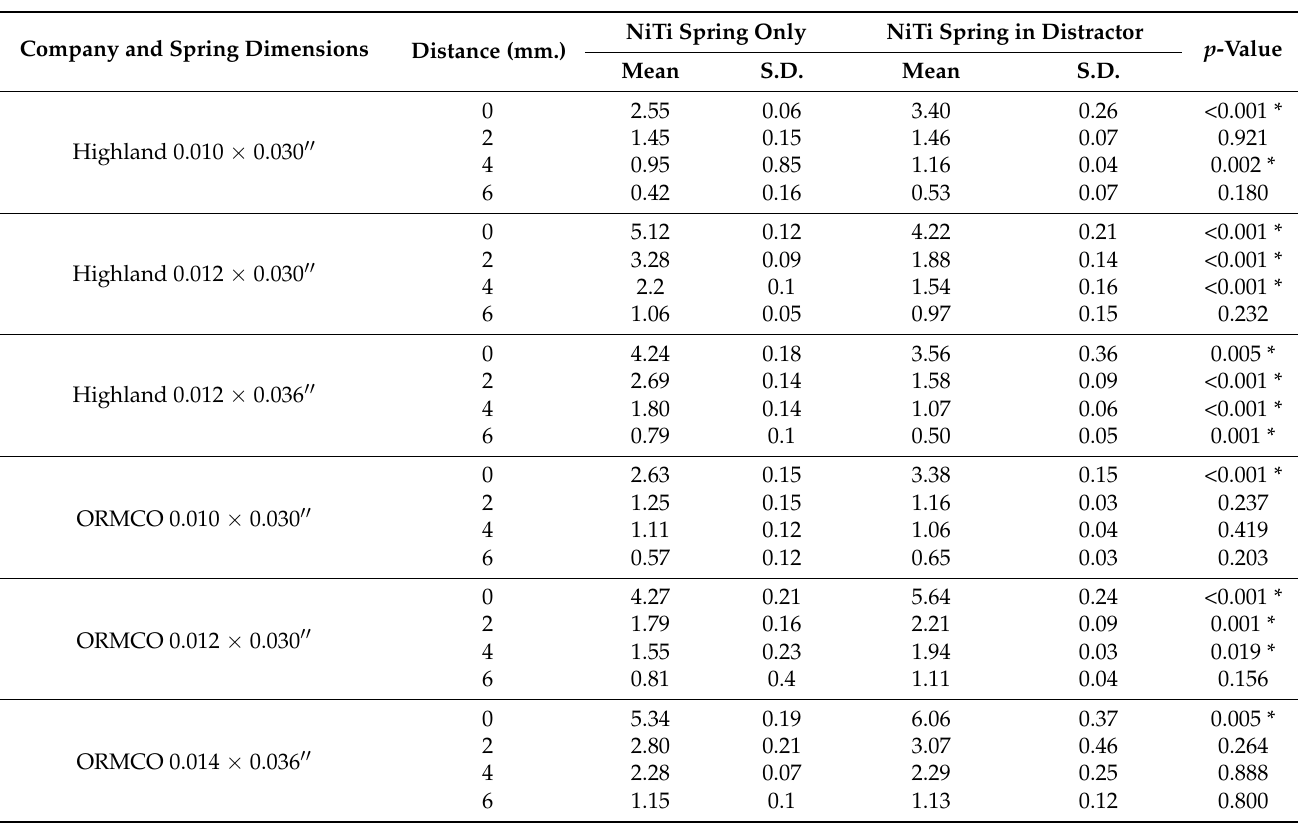
Table 3. Comparison of the mean load between NiTi springs tested with and without the novel alveolar